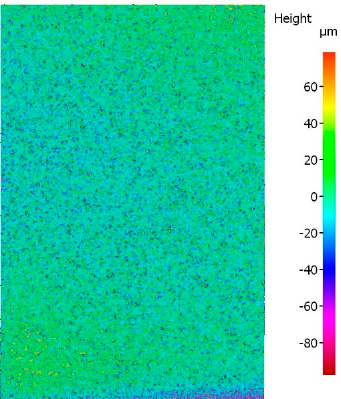
Figure 1. Pseudo − color image of S355 steel substrate after cold iron sandblasting. Figure 1. Pseudo–color image of S355 steel substrate after cold iron